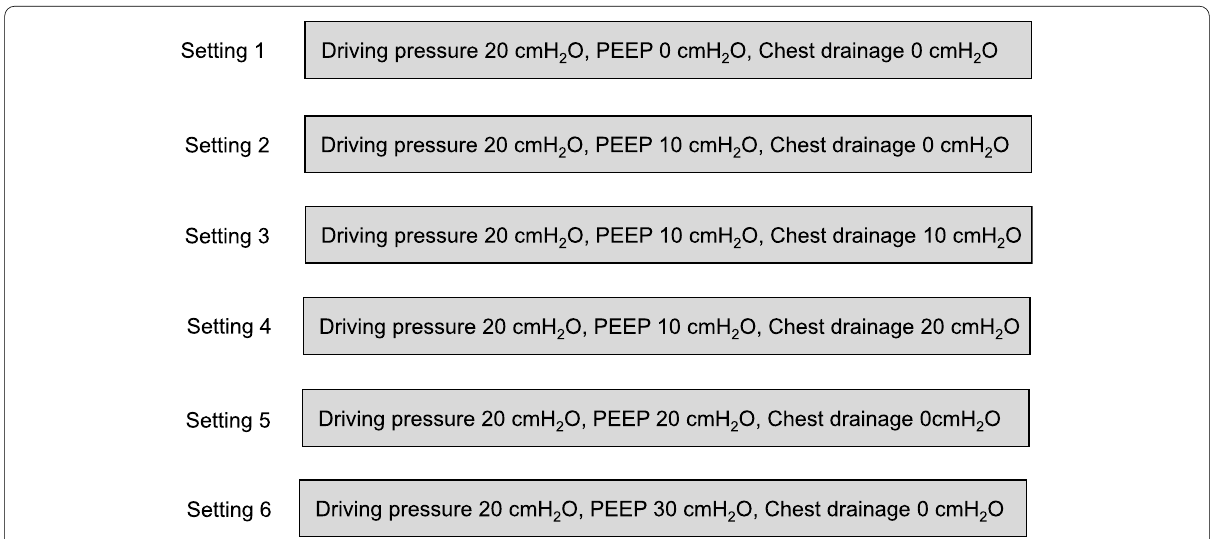
Fig. 2 Experimental protocol. PEEP, positive end-expiratory